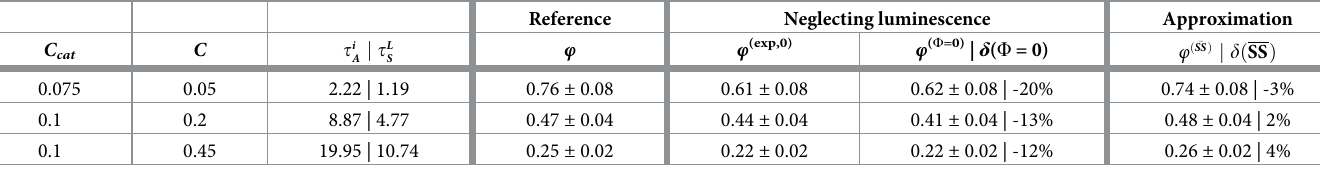
and t L are calculated from Eqs 4 and 6, with � E i ¼ 2556 m 2 : mol (cid:0) 1 for the LED emission A S